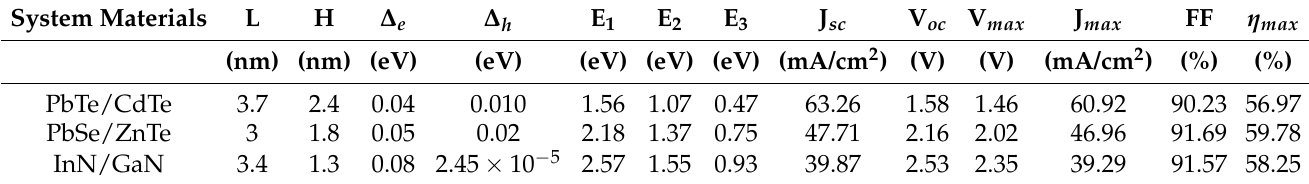
Table 2. Optimum parameters and characteristics of the different material systems of the proposed QD-IBSC